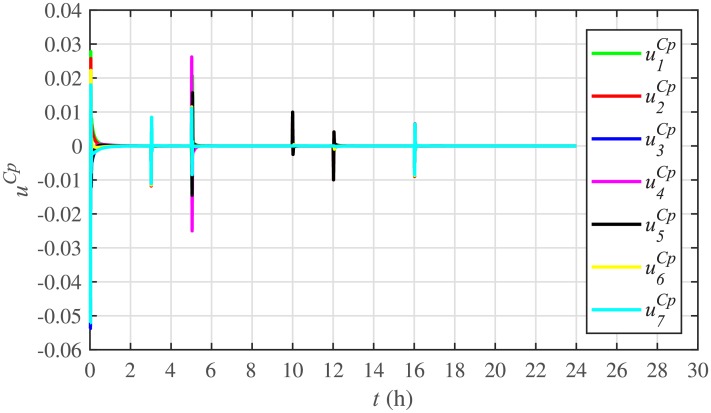
Production costs control efforts under case 2.